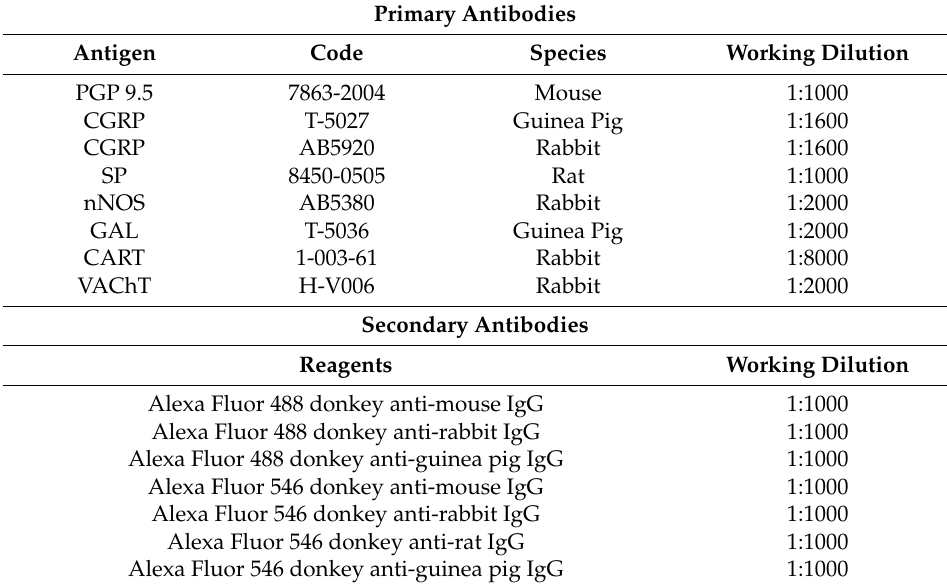
Table 7. List of antisera and reagents used in immunohistochemical